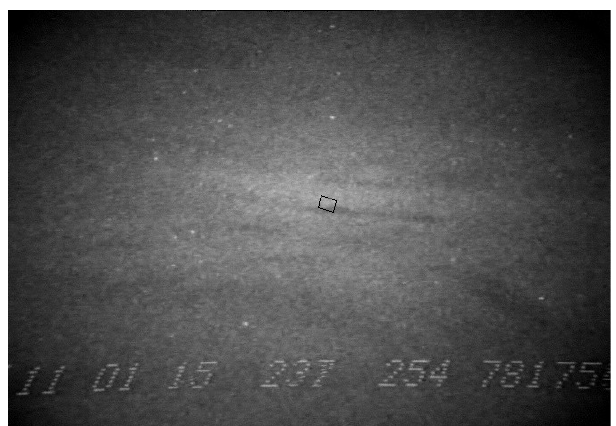
Fig. 13. The all-sky camera image, from 18 January 2007, show- ing the auroral context of the black aurora patches in the magnetic zenith (near the center of the image, marked by small black box). North is down and east is to the